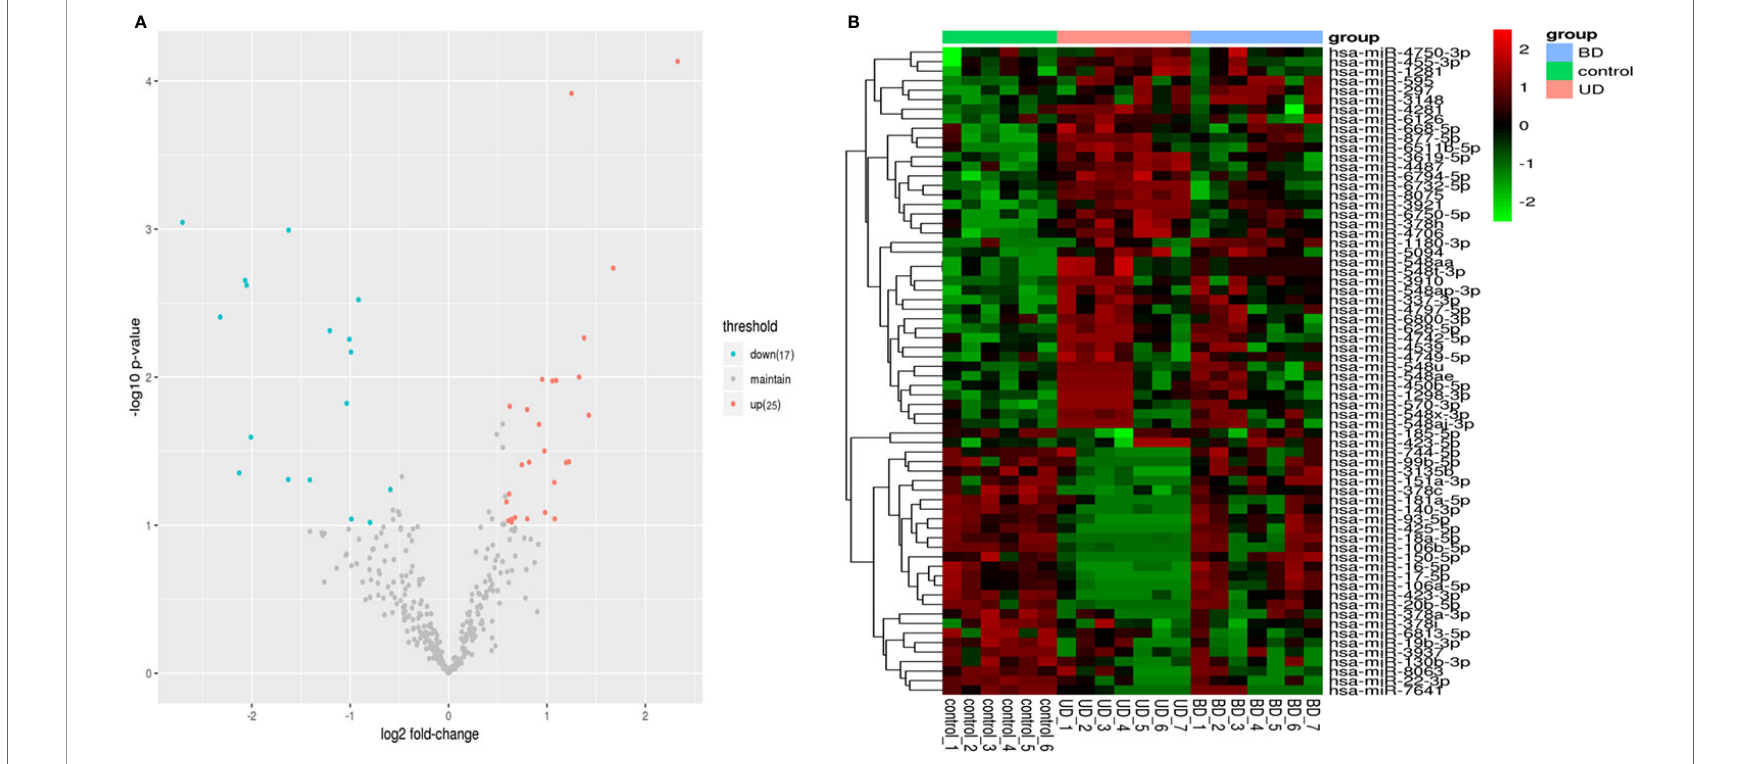
FIGURE 1 | (A) Volcano map of differentially expressed miRNAs. The horizontal axis is the logarithm of the fold change value based on 2, and the vertical axis is the negative logarithm of the p value based on 10. Blue dots represent down-regulated miRNAs with statistically signi fi cant differences in patients comparing healthy subjects. Red dots represent miRNAs that are up-regulated in patients, and grey dots represent miRNAs that have no signi fi cant differences in expression values between the patients and healthy controls. (B) Heat map of differentially expressed miRNAs. The abscissa represents the subject names between groups, and the ordinate represents the differentially expressed miRNAs. Differentiated miRNAs are expressed in red with high expression values and those with low expression values are in